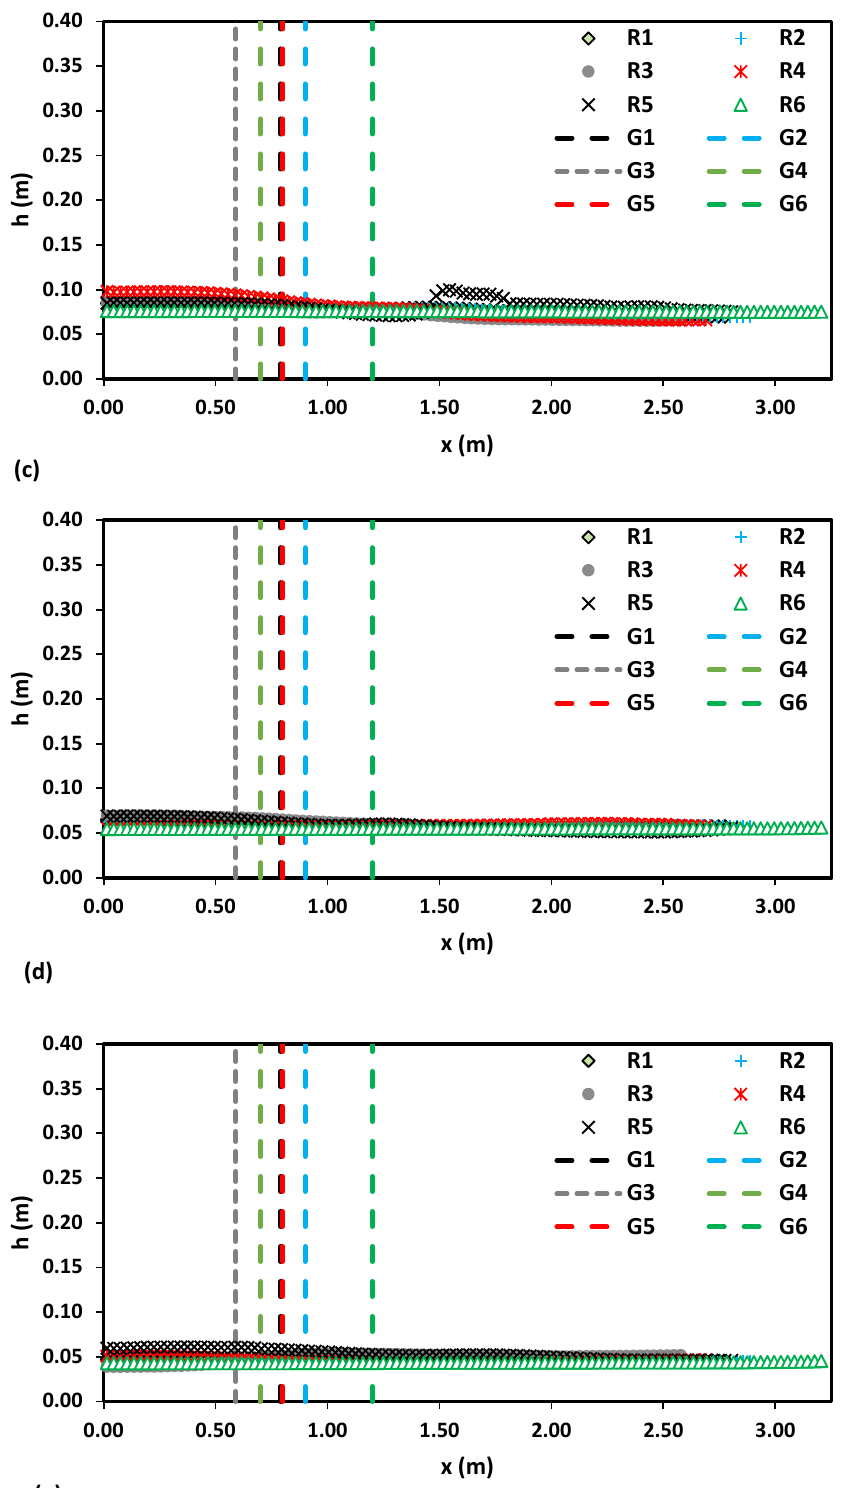
Fig. 13. Water surface profiles (h) along flume length at (a) t = 1 (s), (b) t = 2 (s), (c) t = 3 (s), (d) t = 4 (s) and (e) t = 5 (s). Note: G1-G6 are positions of gates for R1-R6